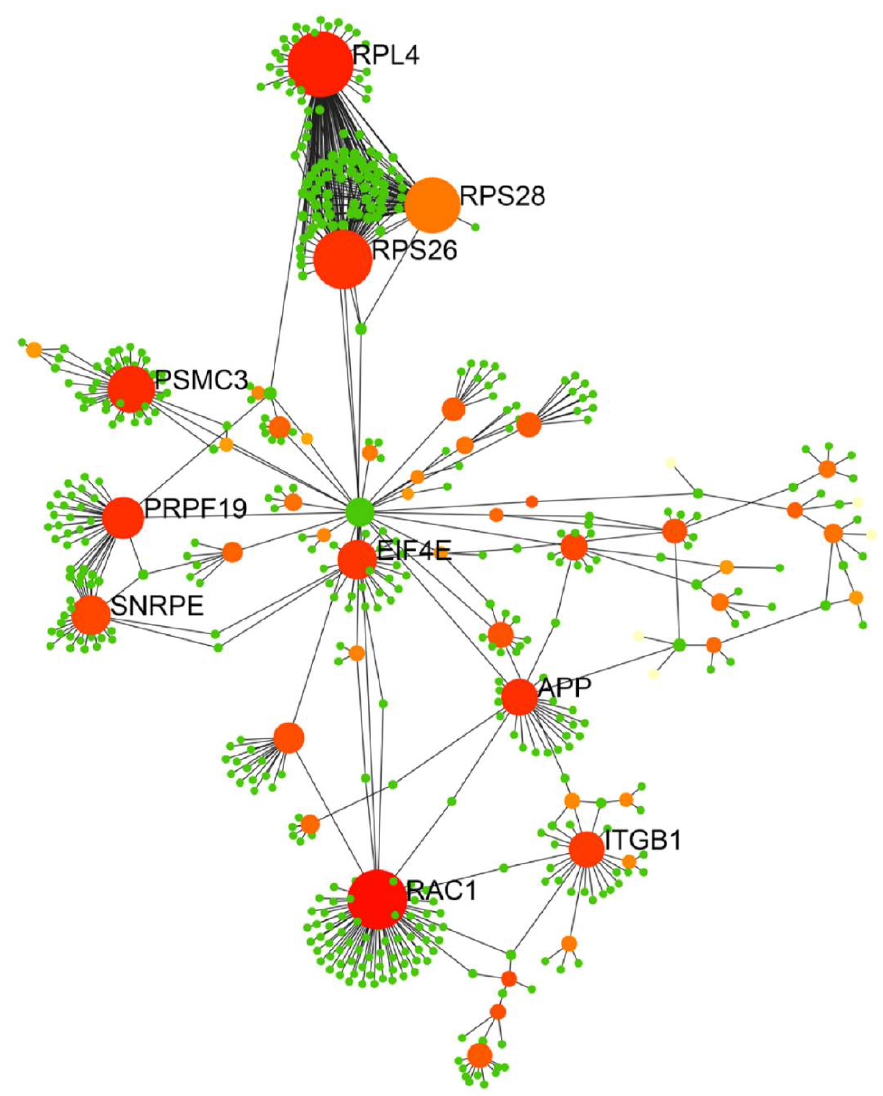
Figure 8. PPI network of 168 exosomal proteins (88 upregulated and 80 downregulated in ADSC-LPS- exo vs. ADSC-exo) identified from the iTRAQ experiments. The PPI networks were constructed by Cytoscape presenting the hub proteins, known to possess the highest degree of connectivity among the protein targets. PPI: protein–protein